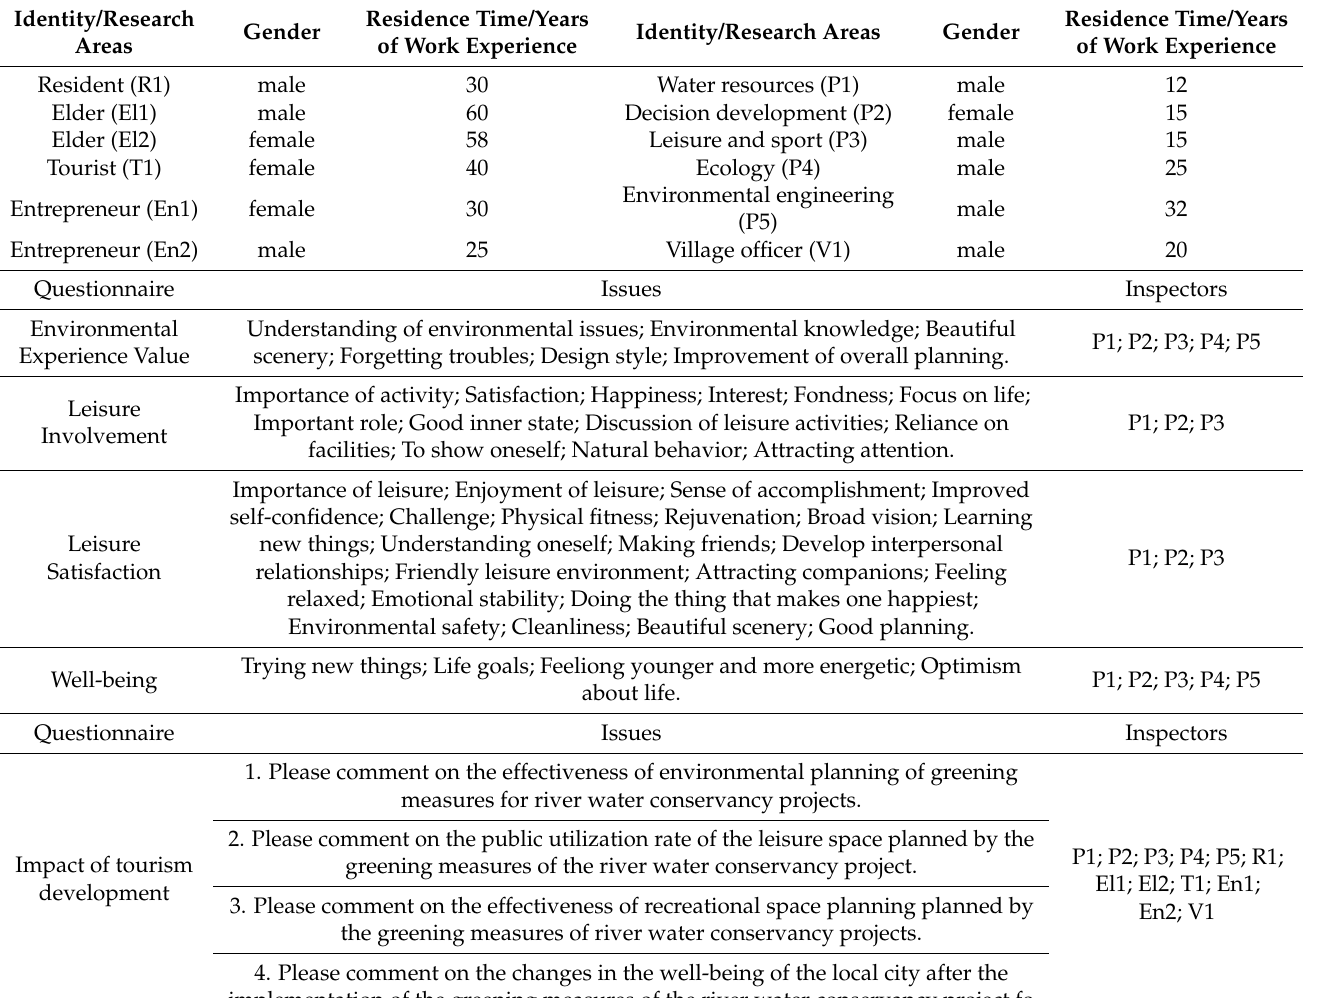
Table 1. Respondents’ background information and an overview of the interview